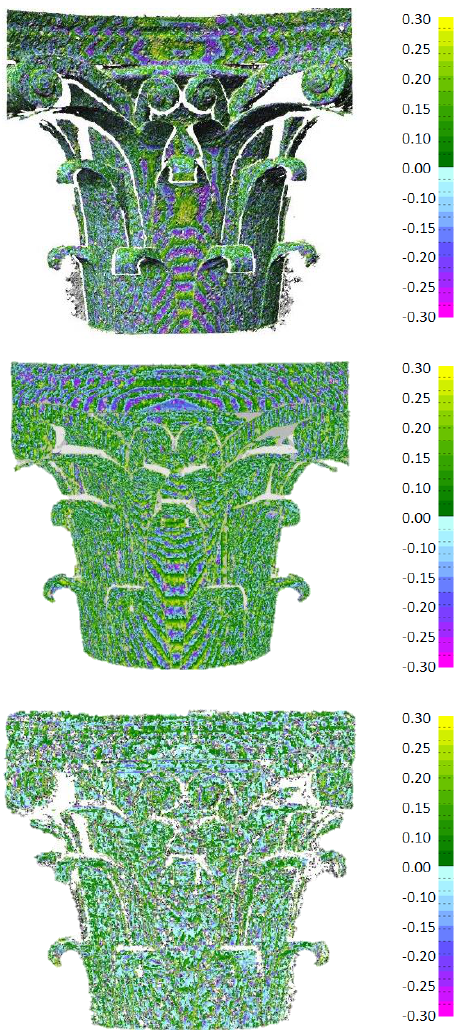
Figure 5: Corinthian Capital error maps (cm). Top : PhotoScan. Center : OpenCV. Bottom : DenseMatcher